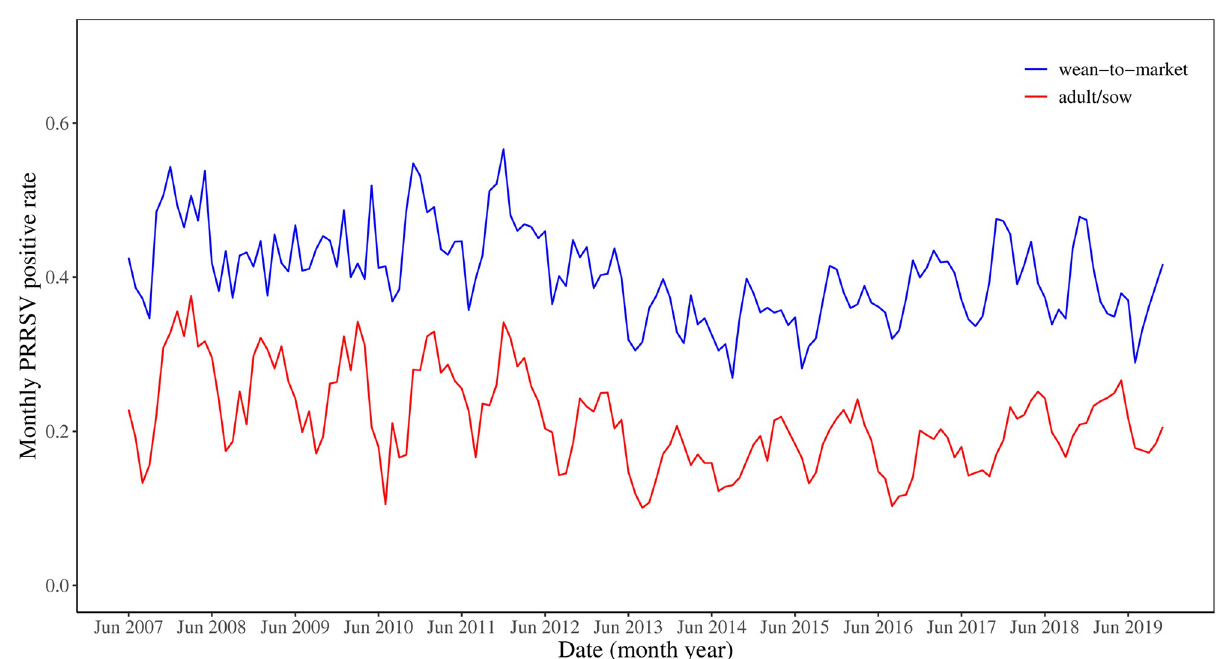
Fig 2. Monthly porcine reproductive and respiratory syndrome virus (PRRSV) positive rate time series by age categories from 2007 to 2019.